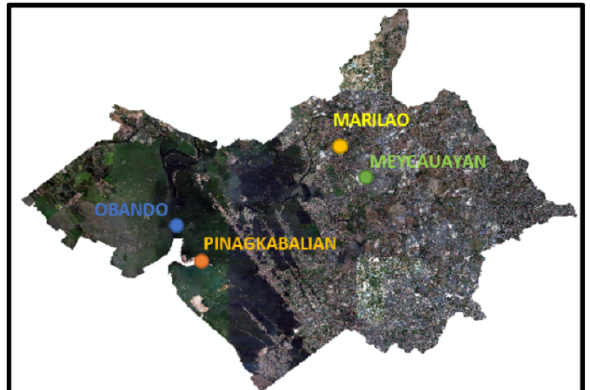
Figure 17. Locations of Hydrograph